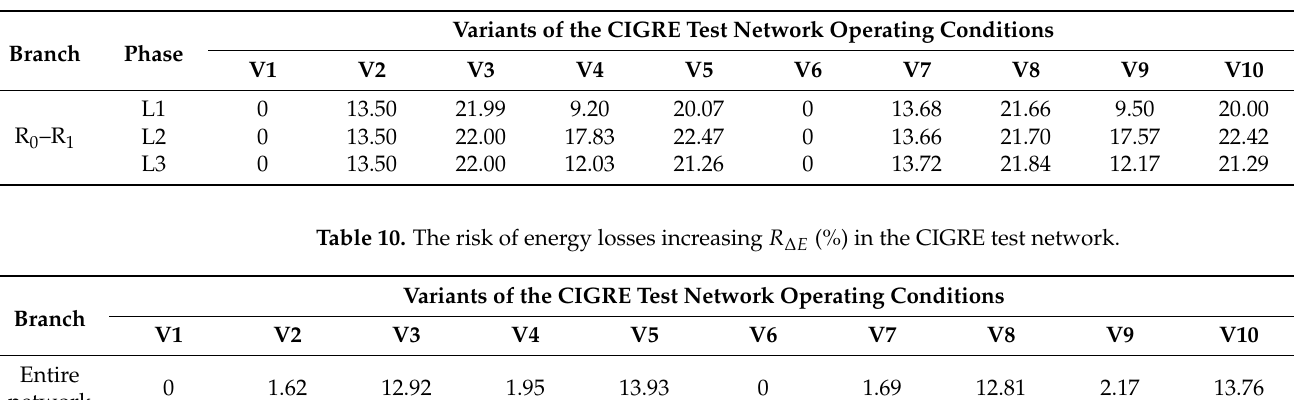
Table 9. The risk of reverse power flow occurring R S